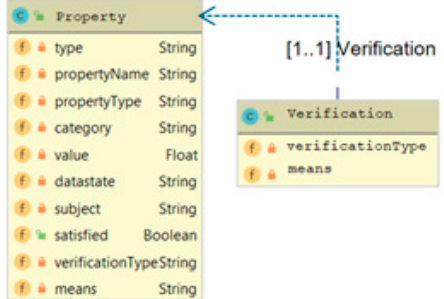
Figure 31. Descriptive overview of Property class.